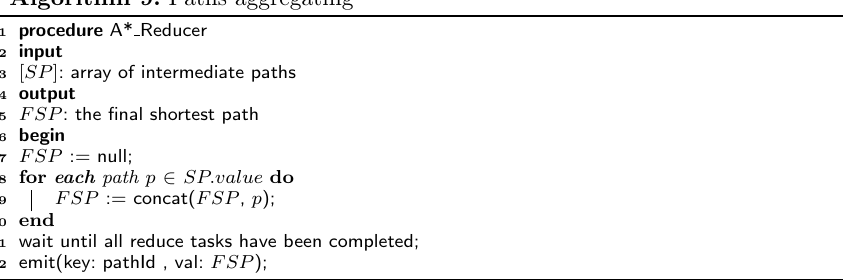
Algorithm 9: Paths